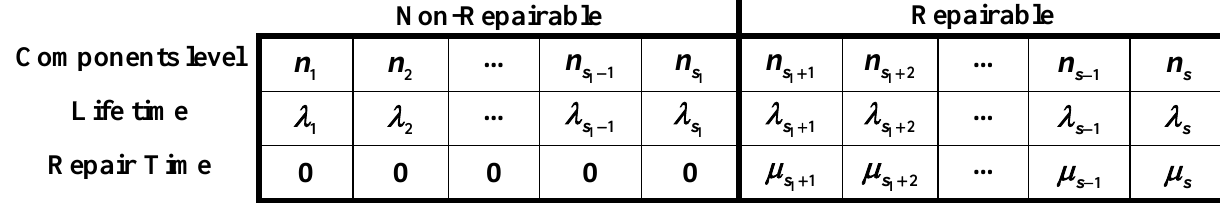
Fig. 2. Chromosome (solution